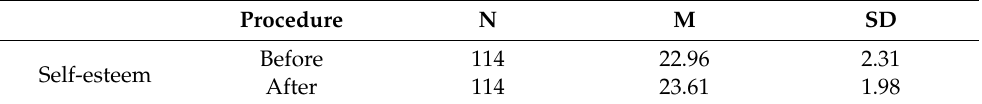
Table 3. Descriptive statistics of patients’ self-esteem before and after the procedure.